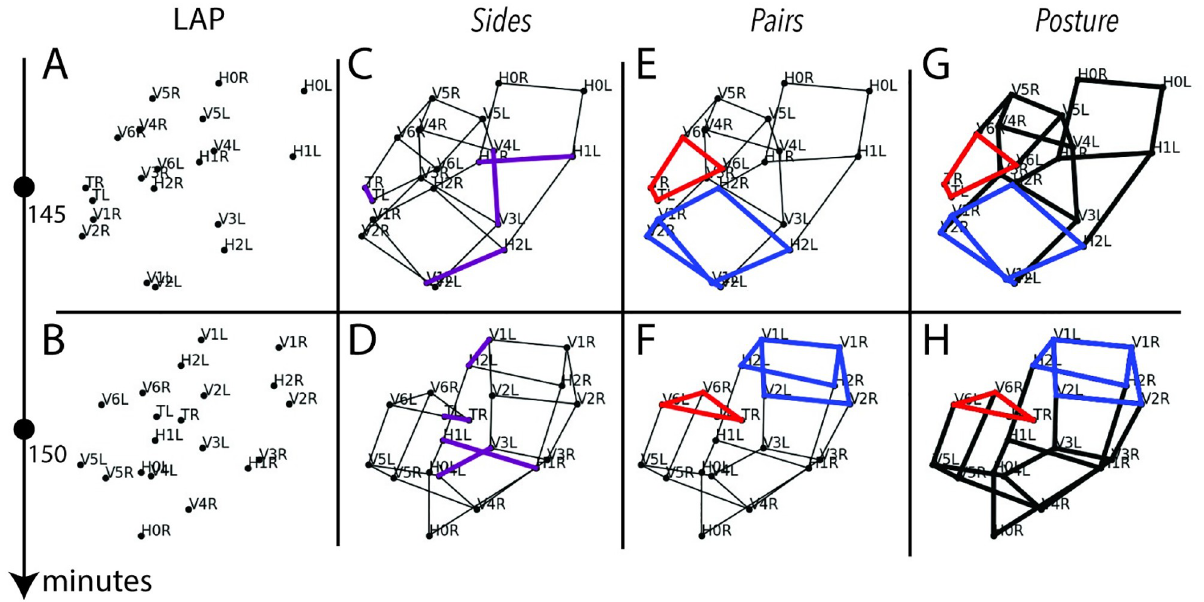
Fig 4. Posture identification applied to the two successive images in Fig 2 according to a series of increasingly intricate models. The embryo repositions between images. A & B: Linear models (LAP) cannot quantify relationships between seam cells; posture identification is impossible without context of neighboring cell identities. C & D: A graphical model ( Sides ) specifies edges (purple) between pairs of seam cell nuclei. Edge lengths are relatively static frame-to-frame, but the similarity of edge lengths throughout the embryo causes the edges to have a weak signal in identifying seam cells. E & F: The Pairs model uses degrees four (red) and six (blue) hyperedges to model a greater local context than is possible in a graphical model. G & H: The Posture model extends the Pairs model to use a degree n 1 (black) hyperedge to evaluate all seam cell assignments jointly.